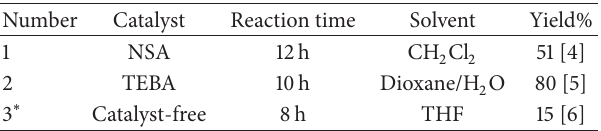
Table 1: Comparison of three methods for the synthesis of Boc- ACLE.